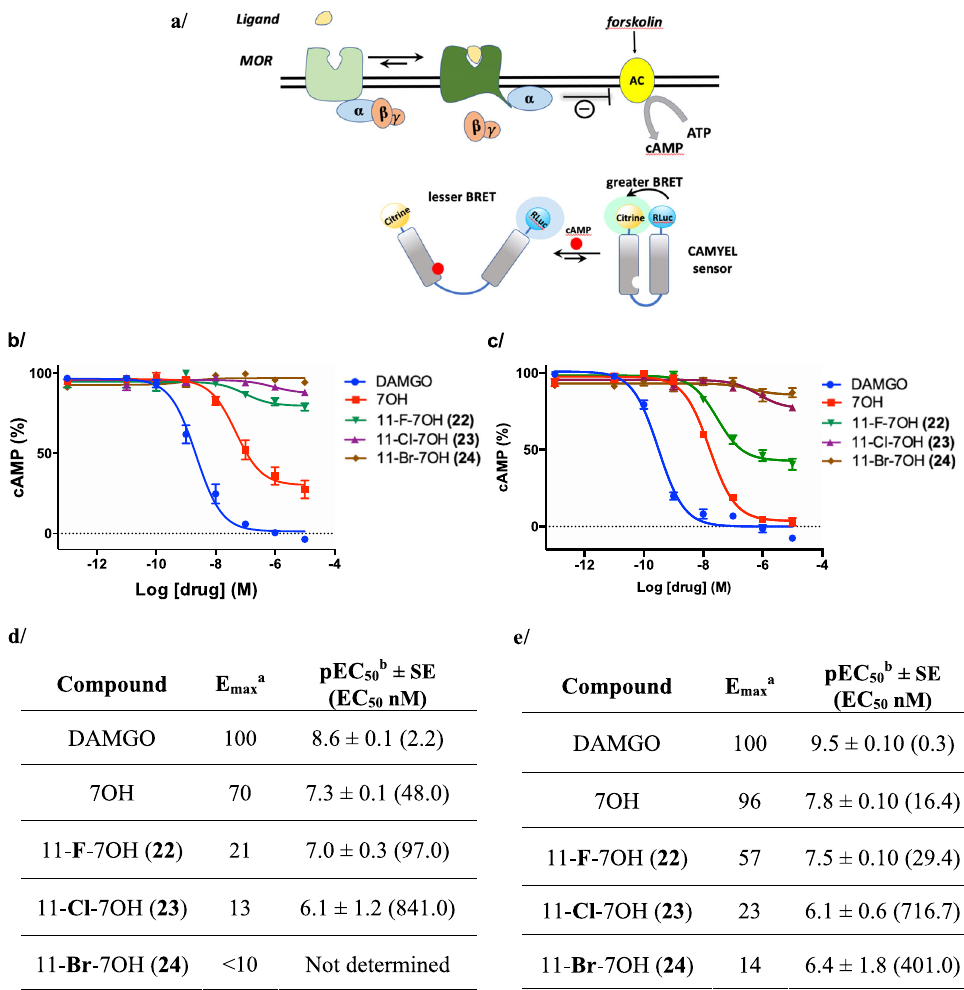
Fig. 6 Activity of 7-hydroxymitragynine (7OH) analogs at the mu-opioid receptor (MOR). a Conceptual representation of the MOR CAMYEL BRET assay. To measure G protein activation, MOR (light green) was coexpressed with G protein subunits G α oB , β 1 , γ 2 , and the BRET CAMYEL sensor. Forskolin activates adenylyl cyclase (AC), which converts ATP to cyclic adenosine monophosphate (cAMP). On activation of mMOR by ligand, α subunit inhibits AC, resulting in a decrease of cAMP accumulation. The CAMYEL sensor is comprised of citrine (mustard yellow) and Renilla luciferase (light blue) with human Epac1 (blue linker) interspaced between them. b Agonist activity of 7OH at mMOR, presented as a percentage of cAMP inhibition produced by the positive control DAMGO ([D-Ala 2 , N-Me-Phe 4 , Gly 5 -ol]-enkephalin); c Agonist activity of 7OH analogs at hMOR; curves represent the average of n = 3, independent experiments with error bars representing ±SEM. d Functional activity of 7OH analogs at mMOR as determined in CAMYEL BRET assays. e Functional activity of 7OH analogs at hMOR as determined in CAMYEL BRET assays [ a Agonist activity indicated by EC 50 values, maximal ef fi cacy is expressed as maximal inhibitory effect on cAMP levels relative to DAMGO ( E max = 100% – cAMP(min)%). b All data points represent − logEC 50 ± SE (EC 50 nM) for n = 3